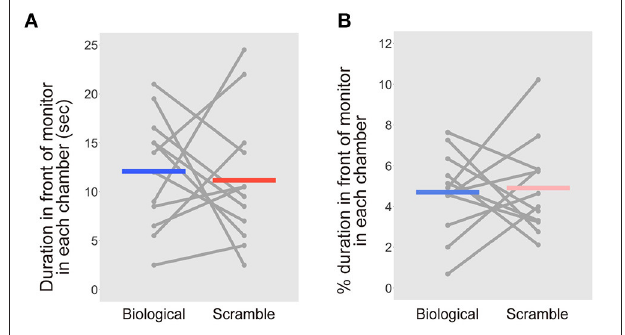
FIGURE 8 | Results of the time spent in front of each monitor, including attentional behaviors, in the Static image test over 2 days ( N = 12). (A) Time spent in front of the monitors. (B) Percentage of duration spent in front of the monitors during the entire time in each chamber. Gray dots and lines indicate the individual data, and horizontal colored bars show the averaged time in each condition.